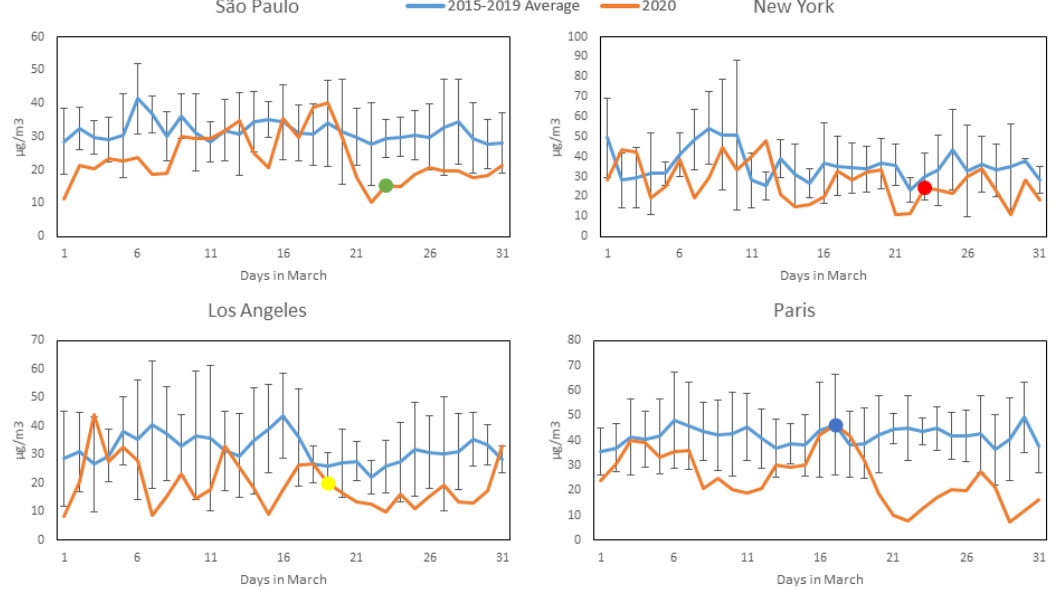
Figure 3. NO 2 concentration profiles during March 2020 (Orange) compared to average and standard deviation of March concentrations over the previous 5 years (Blue) for the four studied cities (most significant COVID-19 intervention date indicated with colored dot). All available station data used for each city (see Section 2.2).